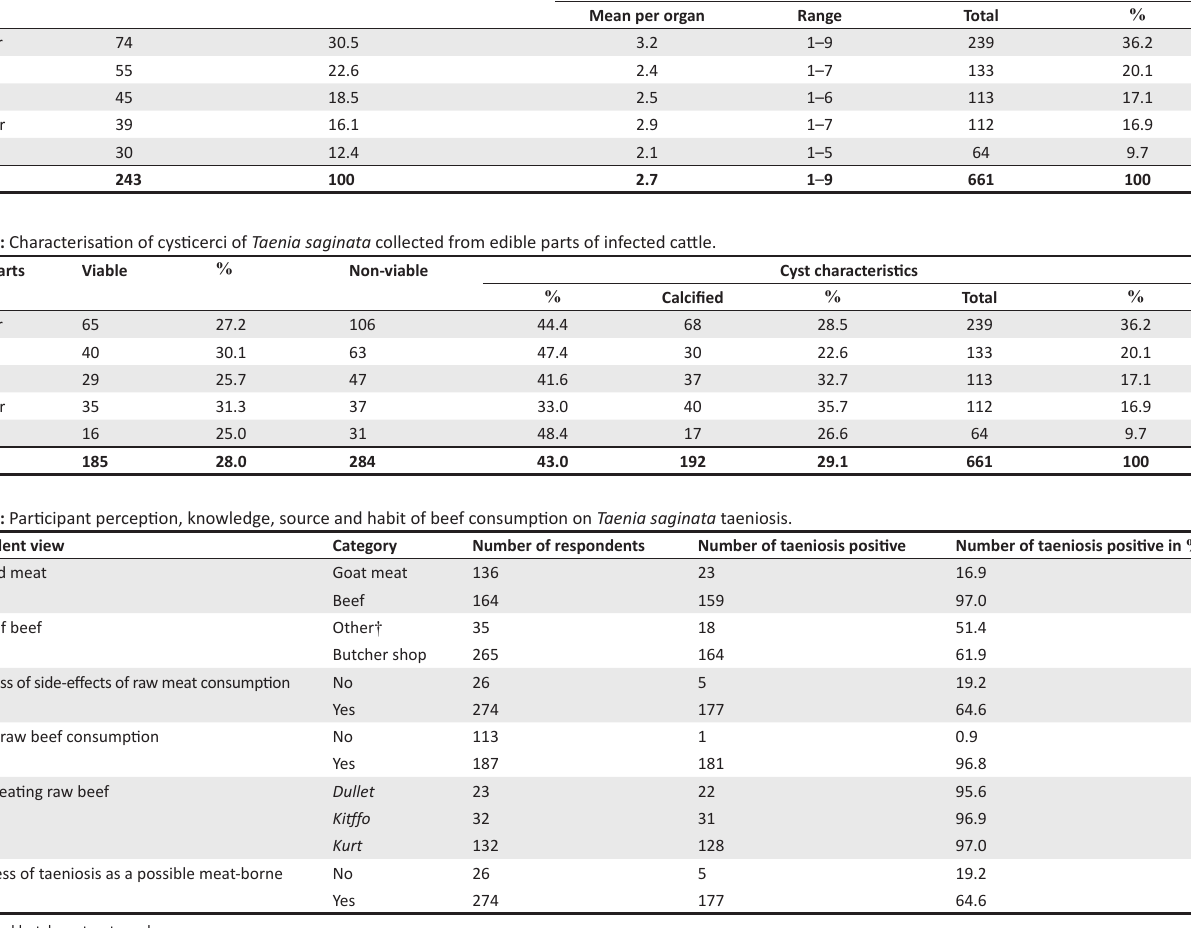
TABLE 3: Distribution of cysticerci of Taenia saginata in edible parts of infected cattle. Edible parts